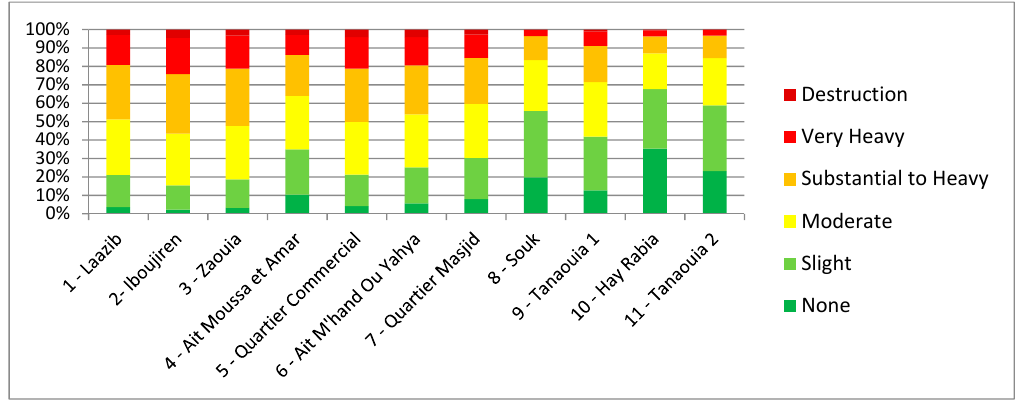
Figure 9. Mean damage grade for the residential buildings of Imzouren according to ( a ) the deterministic scenario and ( b ) the probabilistic scenario.